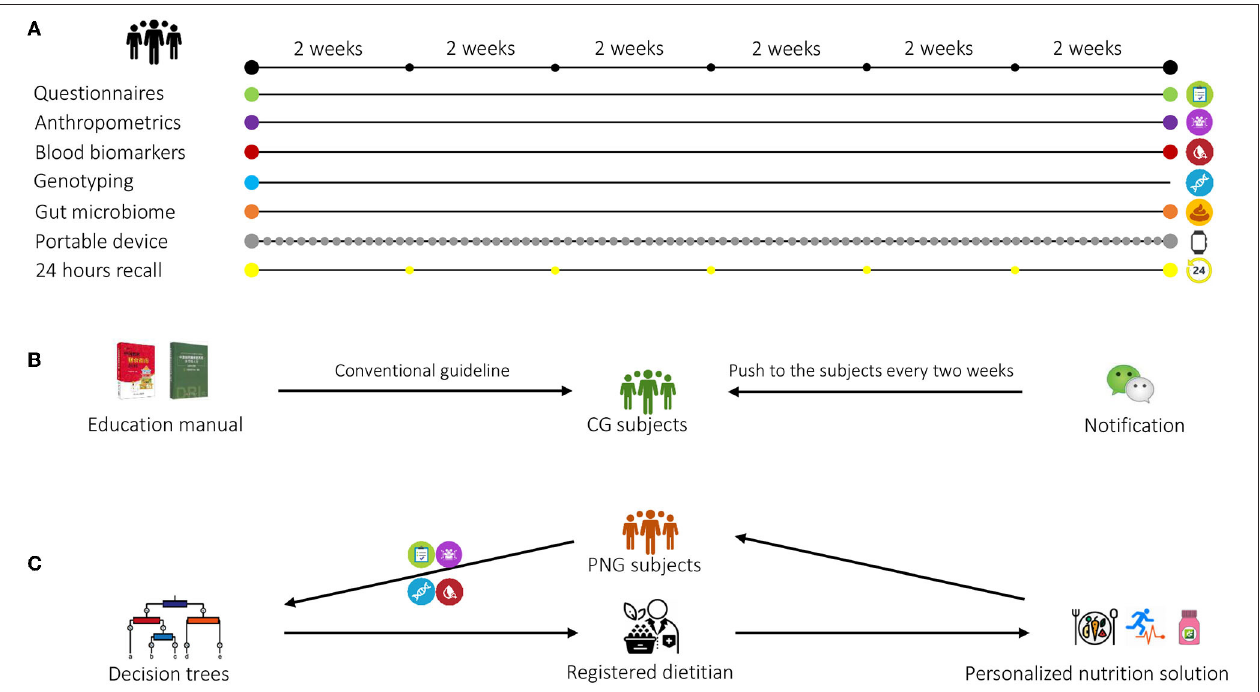
FIGURE 2 | Overview of the study design. (A) Questionnaires, anthropometric measurements, blood, and fecal samples were collected at baseline and at end point. Buccal cells were collected at baseline for genotyping. During the intervention, 24-h recall was collected every 2 weeks, and a portable device was worn every day. (B) The subjects in the control group (CG) received non-personalized, conventional health guidance on diet, physical activity (PA), and nutritional supplements intake based on the Dietary Guidelines for Chinese Residents and Chinese DRIs Handbook . A brochure summarizing the health guidance was delivered to each CG subject at baseline, and follow-up notifications on nutrition education were provided biweekly to these subjects using WeChat. (C) The subjects in the personalized nutrition group (PNG) received personalized nutrition solution on diet, physical activity (PA), and nutritional supplements intake from the registered dietitians based on the decision trees. The personalized solution was updated biweekly based on the subjects’ dietary and PA